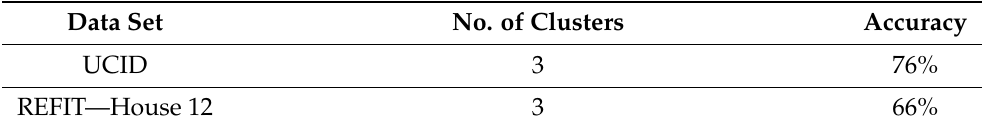
Table 3. Results of training, optimizing, and evaluating a random forest classifier on the cluster labels obtained for the UCID and REFIT